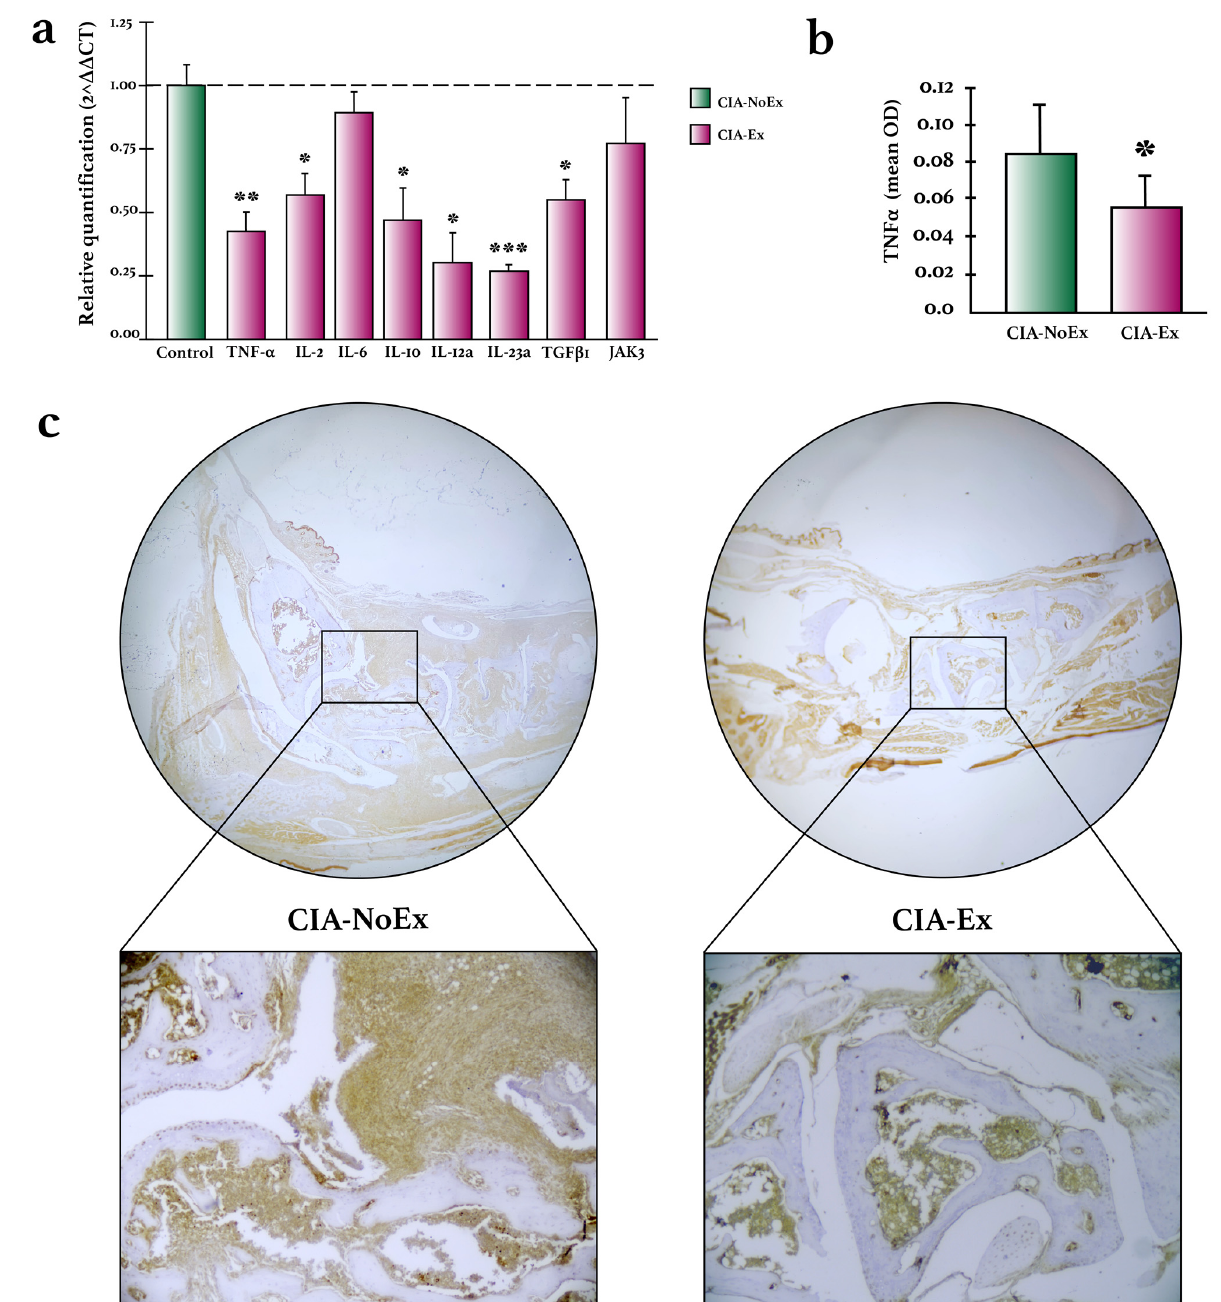
Figure 5. Effects of treadmill physical exercise on inflammatory cytokine expression in the preclinical collagen-induced arthritis in DBA/1 mice. ( a ) Relative quantification of inflammatory cytokines on hind paws joints. RNA expression was determined by RT-qPCR relative quantification through the ΔΔ Ct method using the housekeeping gene RPL13A. ( b ) TNF- α expression was quantified with the ImageJ program and the IHC toolbox in at least 20 microscopic field images from each study subject. The DAB color was extracted from each image, and the maximum and mean gray values were obtained. Each image’s optical density (OD) was obtained with log10 (maximum gray value/mean gray value). The OD means and standard deviations were calculated and graphed by the study group. ( c ) Representative images of TNF- α detection in hind paws joints by immunohistochemistry. Immunodetection was carried out using streptavidin-peroxidase conjugated and DAB as the chromogen. The Mann–Whitney U test was used to determine statistically significant differences. * p < 0.05; ** p < 0.01; *** p <